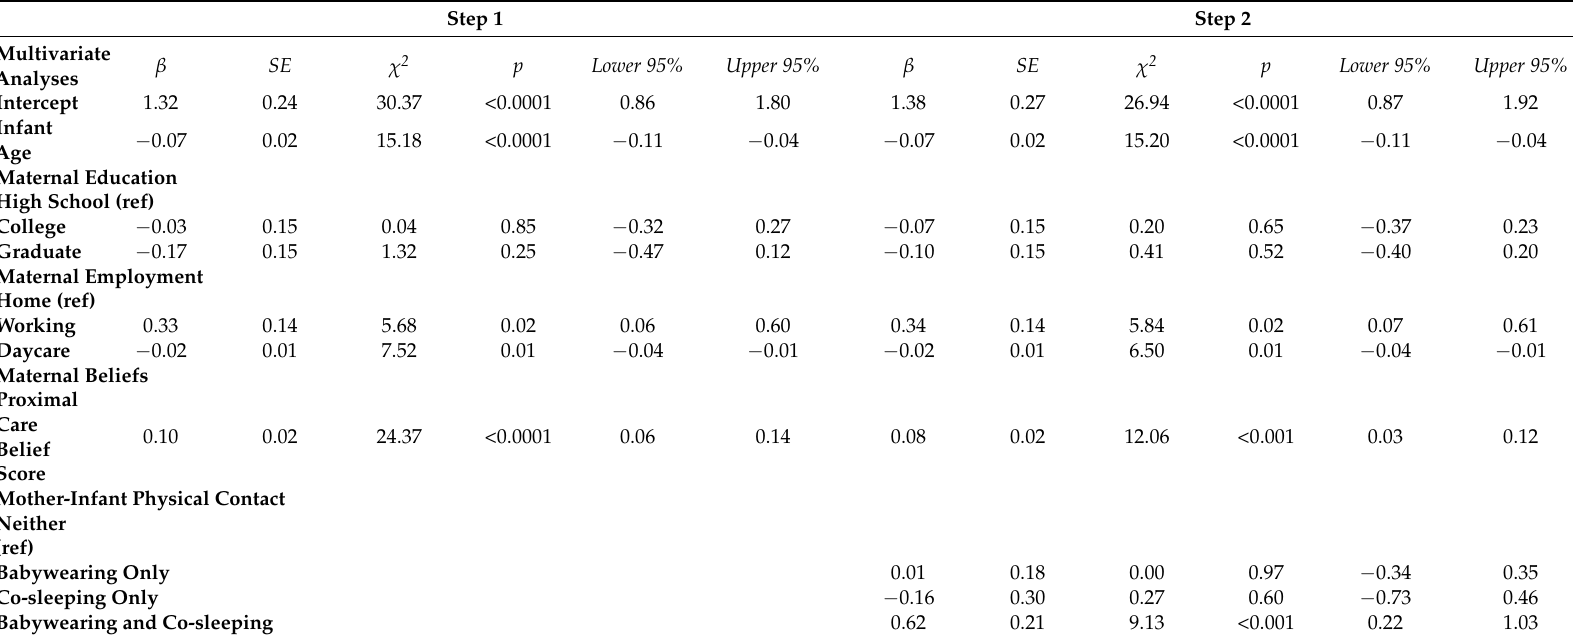
Table 3. Results of the logistic regression predicting responsive breastfeeding philosophy from proximal care practices and beliefs in Study